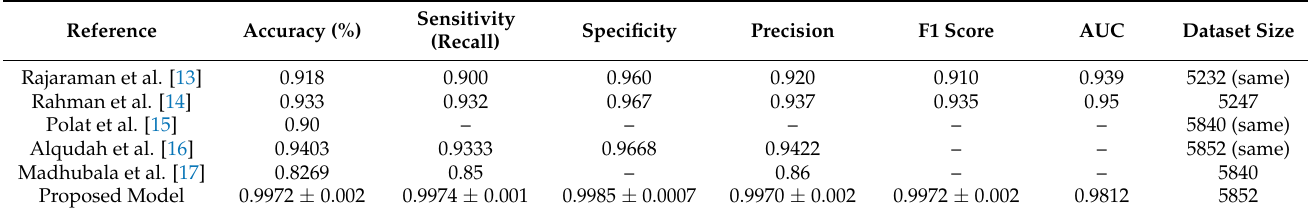
Table 3. Comparison of performance metrics from similar work.